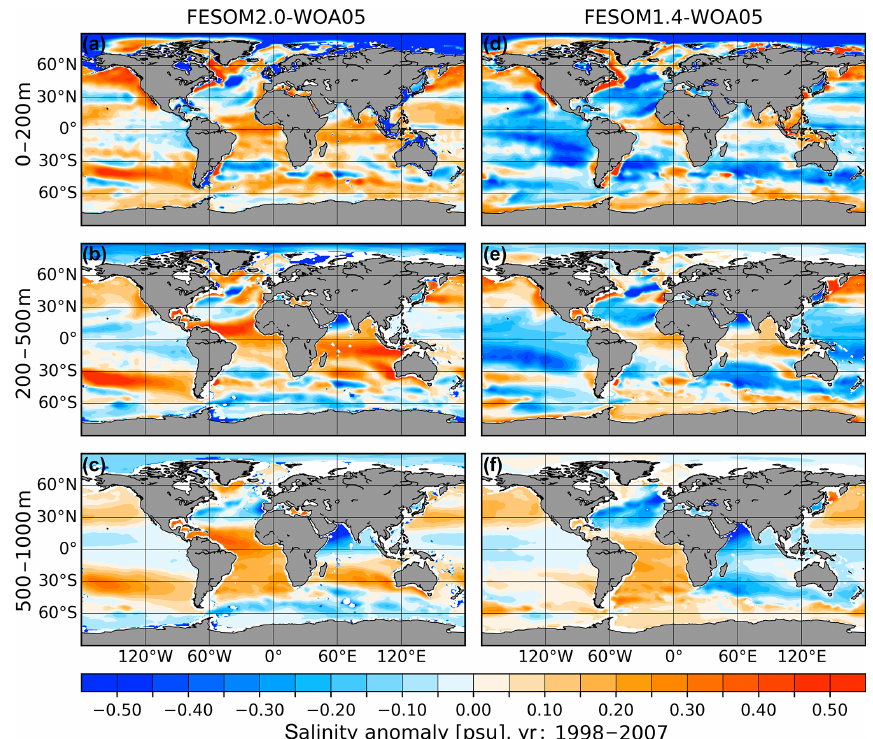
Figure 15. Same as Fig. 14 but for